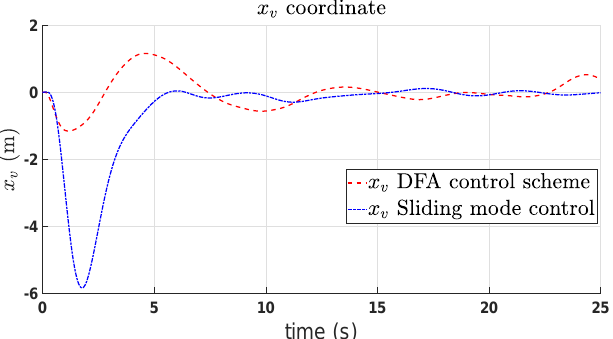
Figure 11. Behavior of x v for the implemented control schemes.